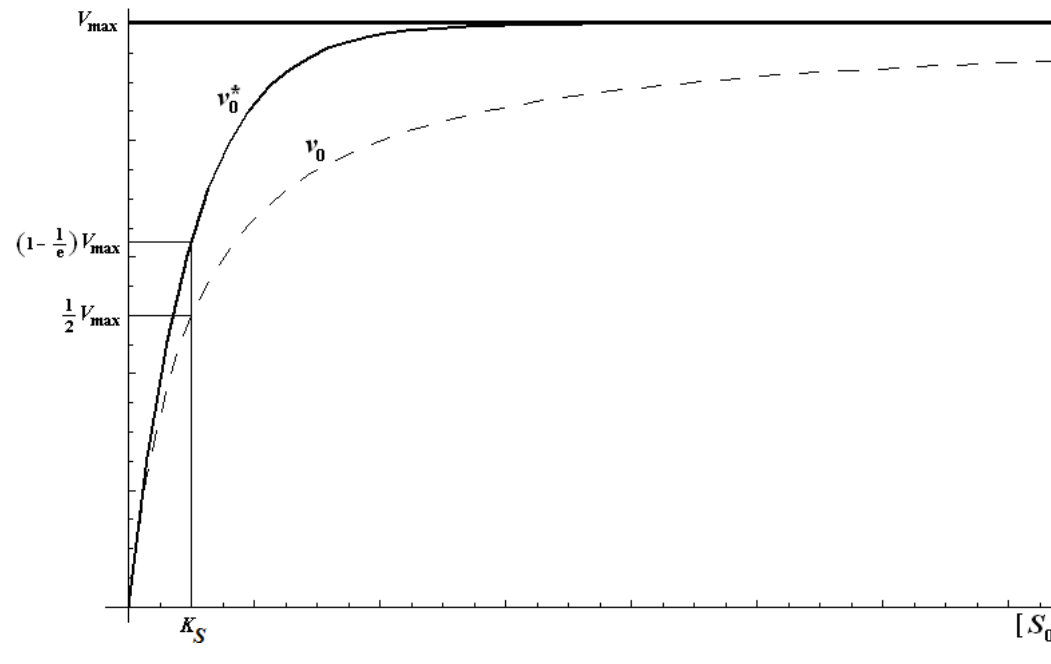
Figure 1. Michaelis-Menten and logistic initial velocities plotted against initial substrate concentration for the E-S mono-substrate enzymic reaction. The dashed curve corresponds to the Michaelis-Menten equation (1) while the continuous thick curve represents its logistic generalization from